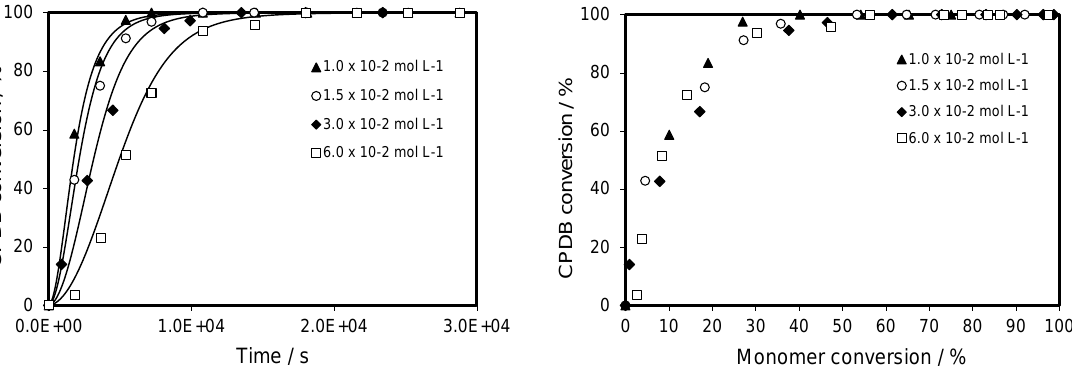
Figure 4. Evolution of CPDB conversion versus reaction time and of monomer conversion versus CPDB conversion for CPDB-mediated polymerization of TBDMSMA in toluene at 70 °C with initial concentration of CPDB ranging from 1.5 × 10 −2 to 6.0 × 10 −2 mol·L −1 . The graph compares predicted values (lines) with experimental data (points).